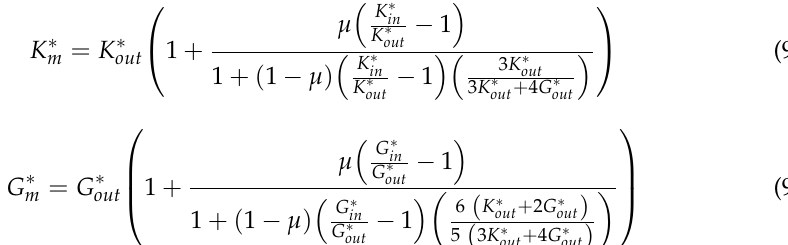
Figure 15. Effective elastic moduli of composite reinforced by randomly CNT inclusion in PP matrix, in function of 𝜂 for 𝜇 = 0.35 with a maximum of Young’s modulus 𝐸 (cid:3040)∗ and minimum of Poisson’s in function of η for µ = 0.35 with a maximum of Young’s modulus E ∗ m and minimum of Poisson’s ratio 𝜈 (cid:3040)∗ : ( a ) effective Young’s modulus 𝐸 (cid:3040)∗ ; and ( b ) effective Poisson’s ratio 𝜈 (cid:3040)∗ . ratio ν ∗ m : ( a ) effective Young’s modulus E ∗ m ; and ( b ) effective Poisson’s ratio ν ∗ m